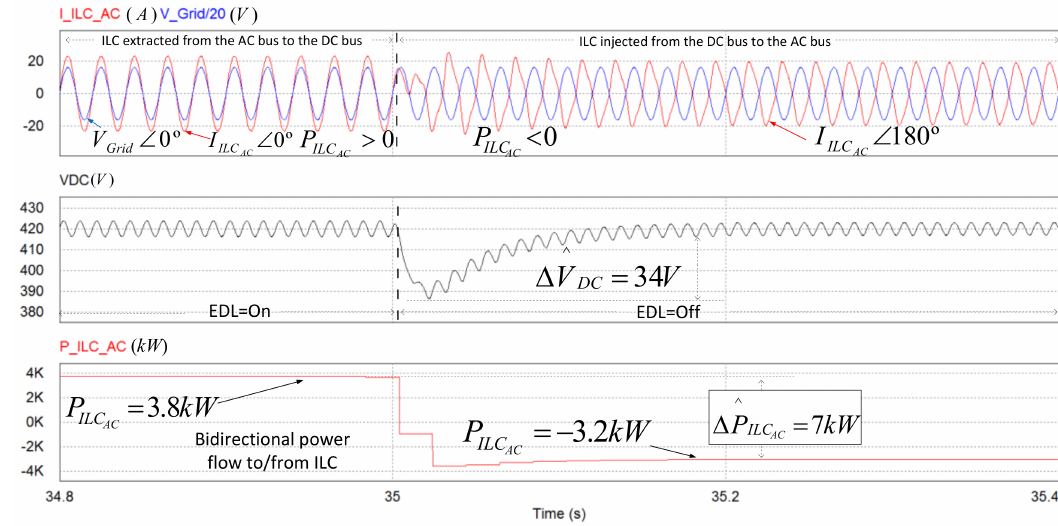
Figure 8. Simulation waveforms of the most sudden transients of I ILC_AC , V DC and P ILC_AC